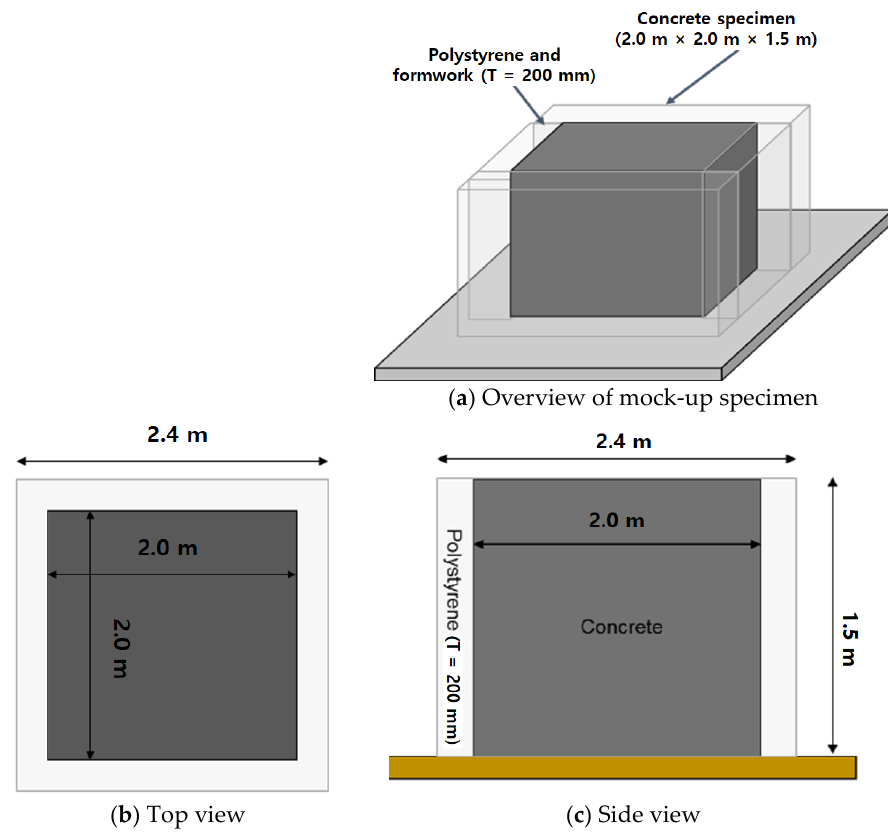
Figure 13. Dimension of Mock-up specimen. Table 15. Test result of fresh concrete produced from batch plant.